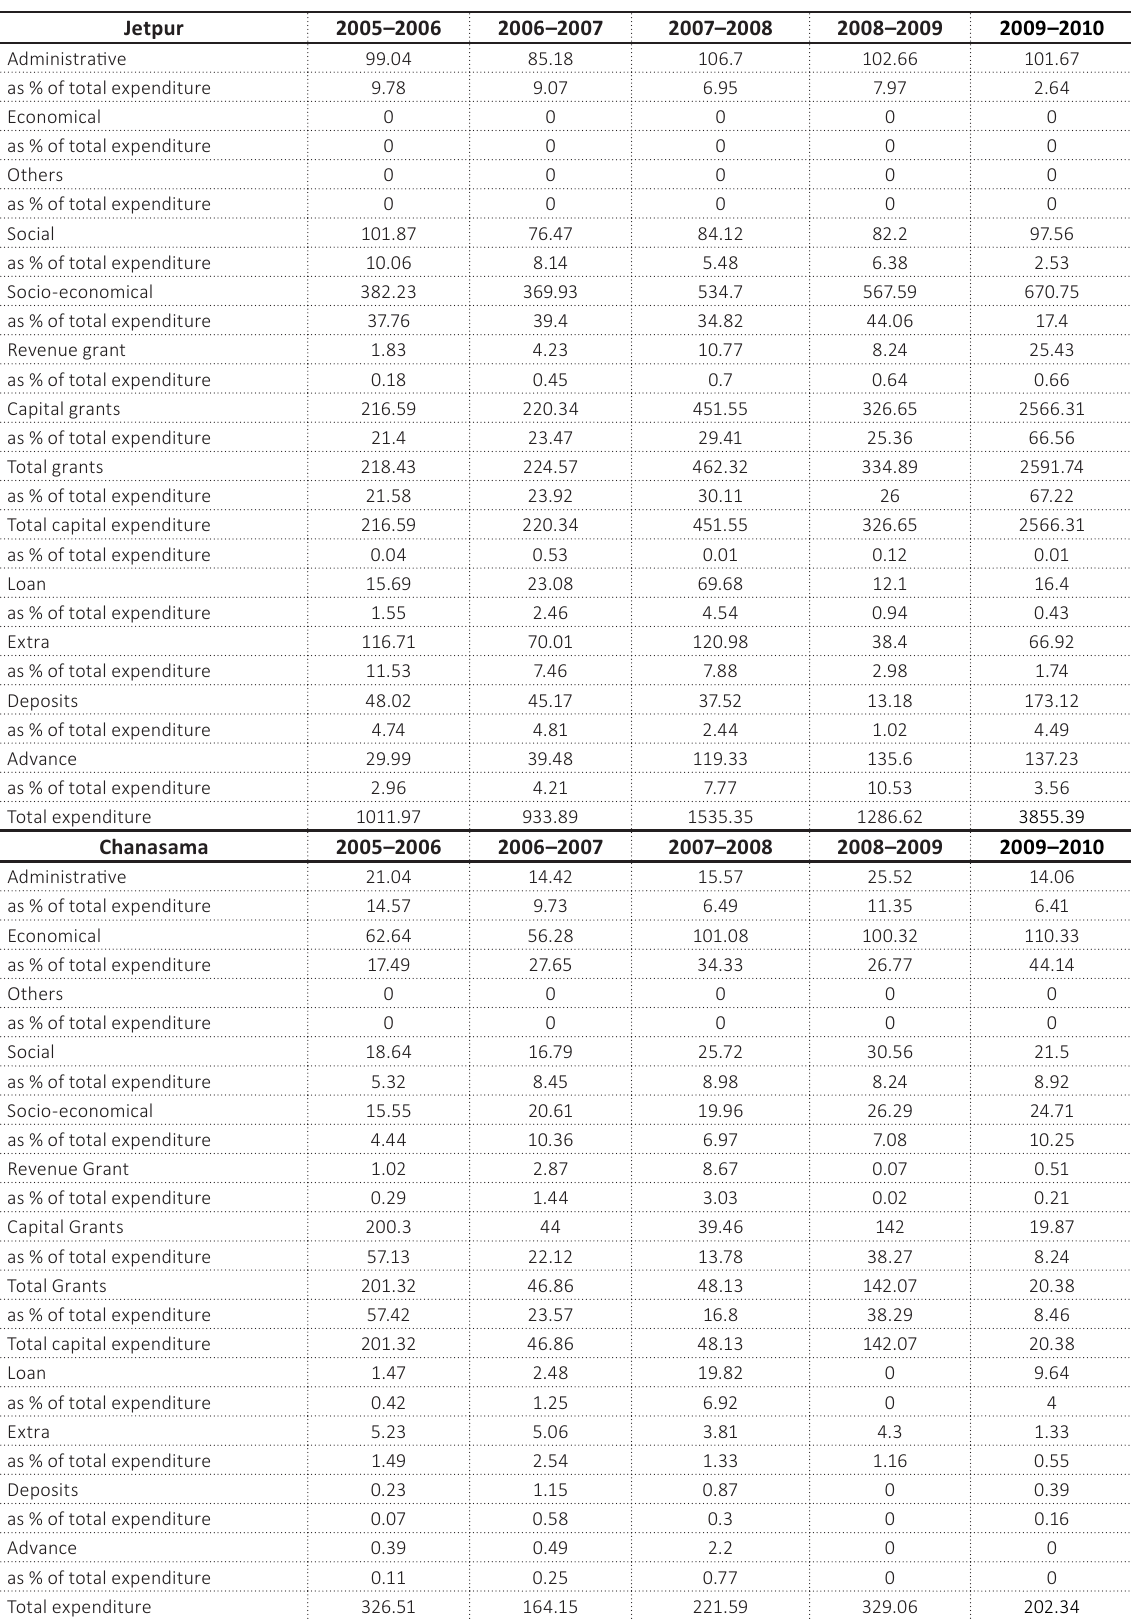
Table A1 (cont.). Total expenditure (Rs in